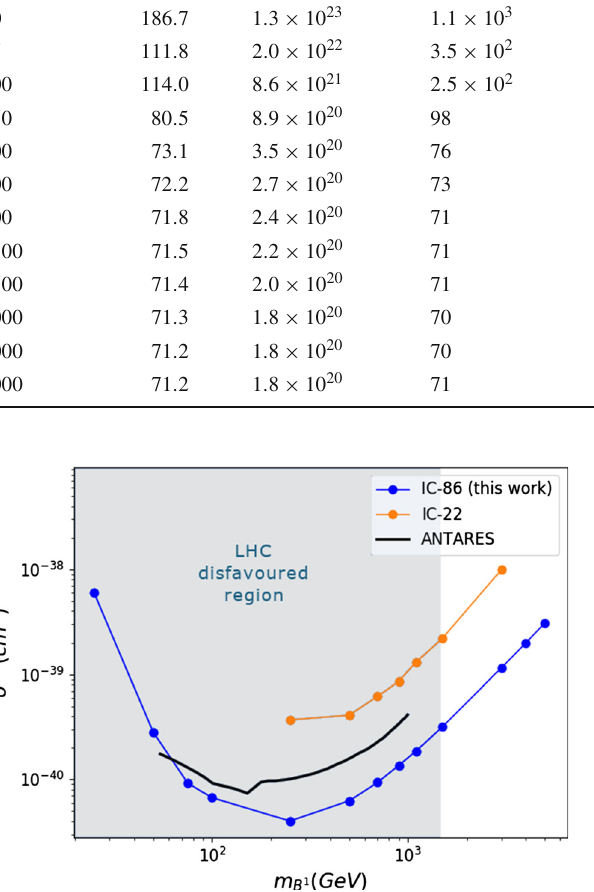
erably improves over those published in Refs. [21] and